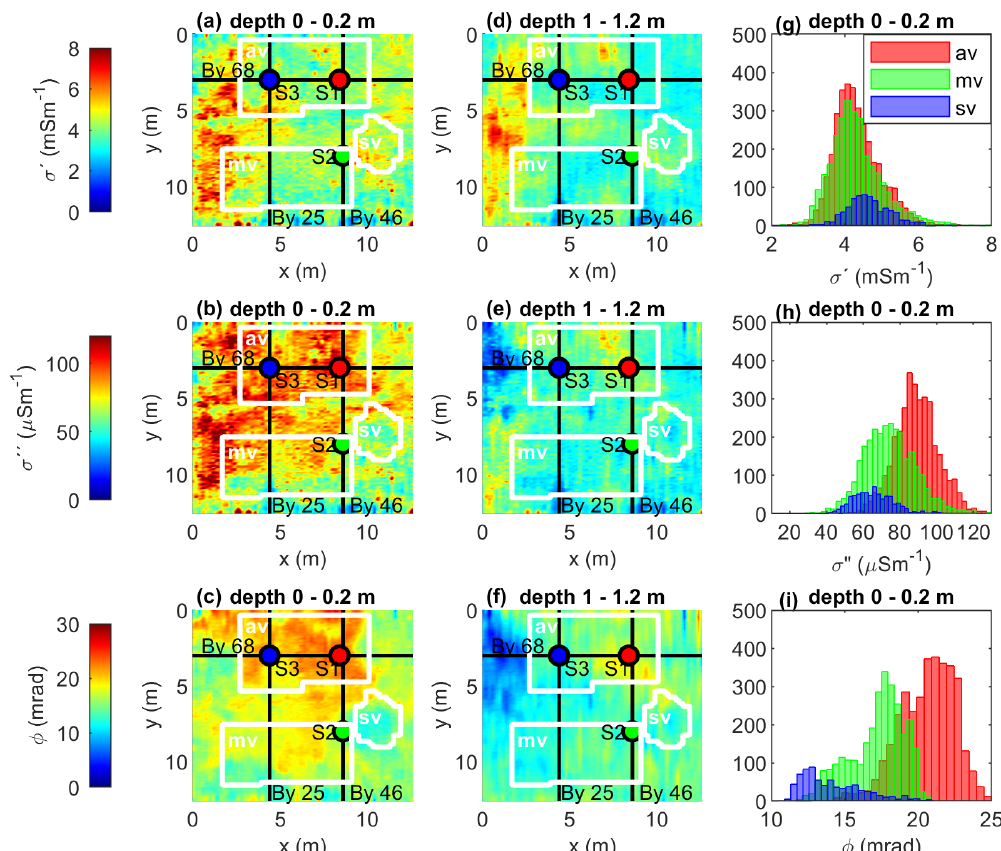
Figure 8. Maps of the complex conductivity at different depths. The black lines indicate the profiles By 25, By 46, and By 68. The dots represent the locations of the vertical sampling profiles S1, S2, and S3. The white lines outline areas classified as (av) abundant vegetation, (mv) moderate vegetation, (sv) sparse vegetation, and histograms of the complex-conductivity imaging results of the masked areas, the abundant vegetation (red bins), the moderate vegetation (green bins), and the sparse vegetation (blue